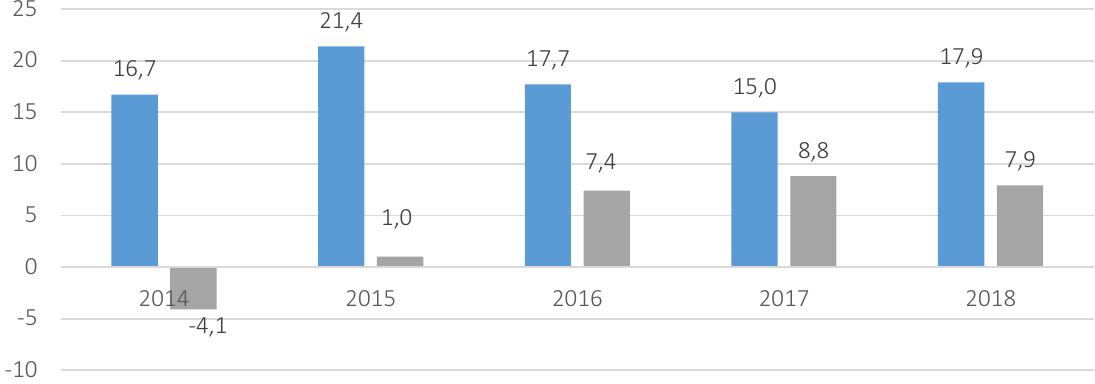
Figure 5. The ratio of interest rates on loans and average profitability for 2014–2018, %